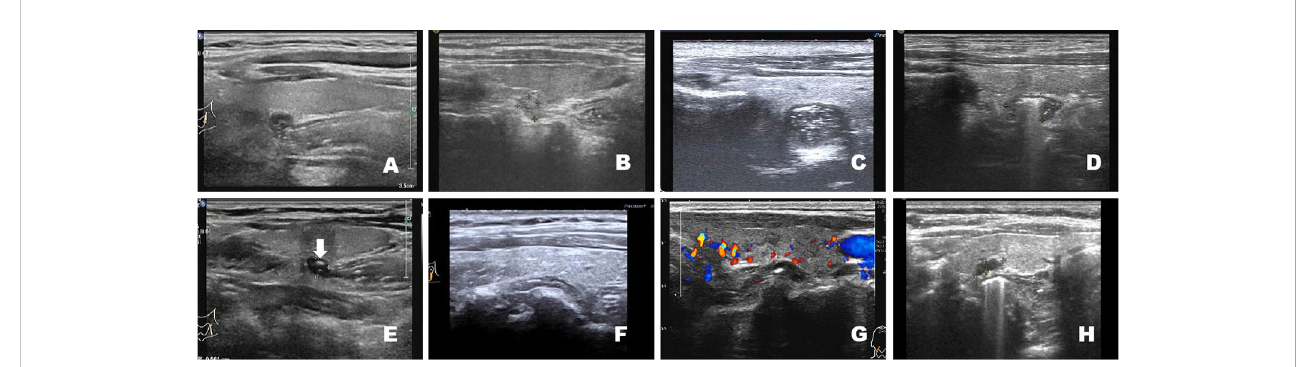
FIGURE 1 Compared with the echogenicity of the thyroid gland, solid nodular diverticula are classi fi ed as solid hypoechoic nodular diverticula (A) , image from a 29-year-old woman), solid isoechoic nodular diverticula (B) , image from a 56-year-old man), and solid high-low echogenic intermixed nodular diverticula (C) , image from a 34-year-old woman). Air-containing nodular diverticulum. The lesion contains a central strongly echogenic area associated with a comet-tail artifact. The presence of gas can be seen, and the tail pattern changed during swallowing (D) , image from a 32-year-old man). Liquid- containing nodular diverticulum with echoless interior (E) , white arrow, image from a 46-year-old man). Atypical diverticular changes: Regional convexities of the esophageal wall with no obvious nodules (F) , image from a 64-year-old man; (G) , image from a 51-year-old man; (H) , image from a 53-year-old woman).